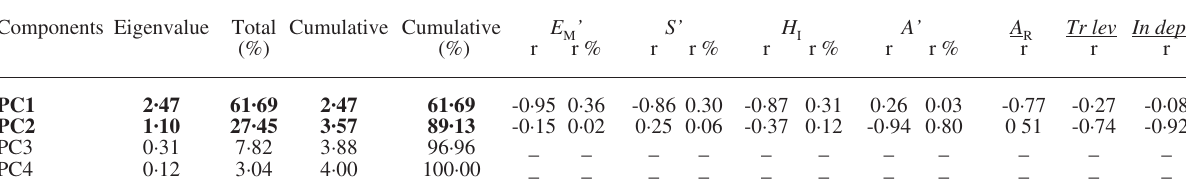
’ : muscular-skeletal amount per unit length, S’ : body size-standardised caudal fin span, H Table 7. – Pca component statistics, active ( E : m i hepatosomatic index and A’ : body size-standardised caudal fin area) and supplementary ( A : caudal fin aspect ratio, Tr lev : trophic level and r In dep : depth inhabited) variable correlations (r) with principal components (Pc1, Pc2) and active variable relative contributions (r %) to data ordination in the Pca analysis. the components used for data ordination are in bold and the supplementary variables are underlined. components eigenvalue total cumulative cumulative